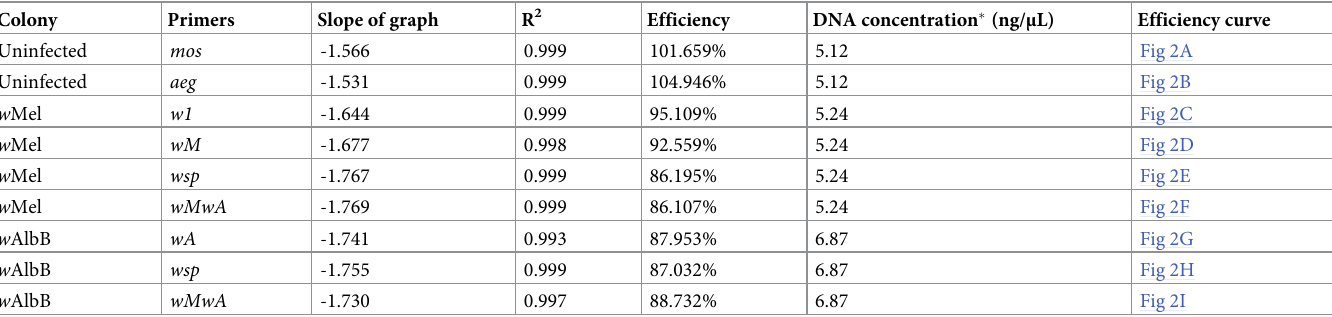
� Template DNA was extracted in 250 μ L 5% Chelex 1 100 Resin and then diluted ten times before making a three-fold dilution series. Concentration was measured before